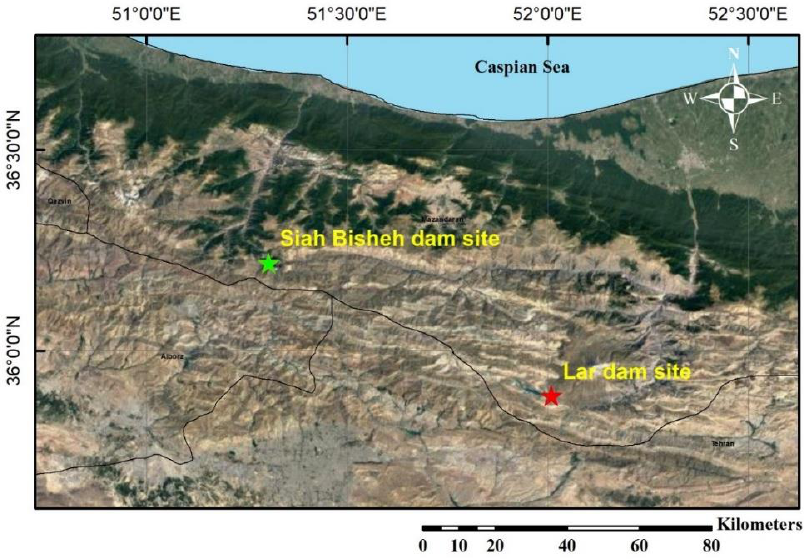
Figure 1. Location of the studied dam sites (Stars show location of the dam site).